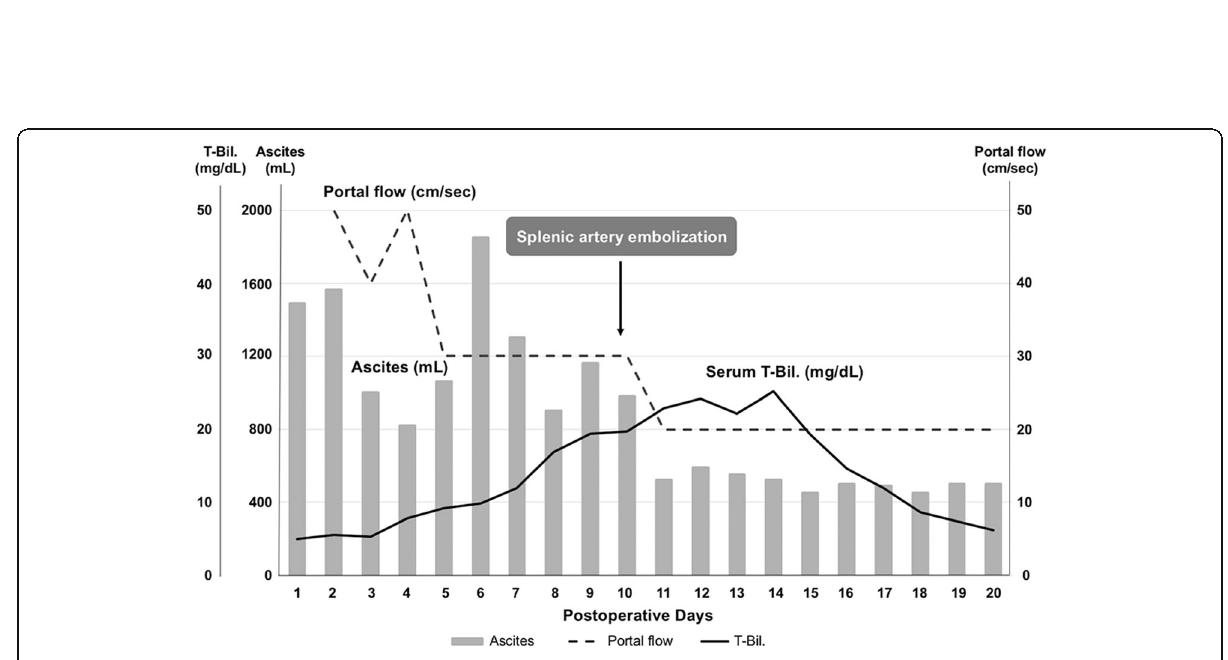
Fig. 2 Clinical course and laboratory workup after living donor liver transplantation pre- and post-splenic artery